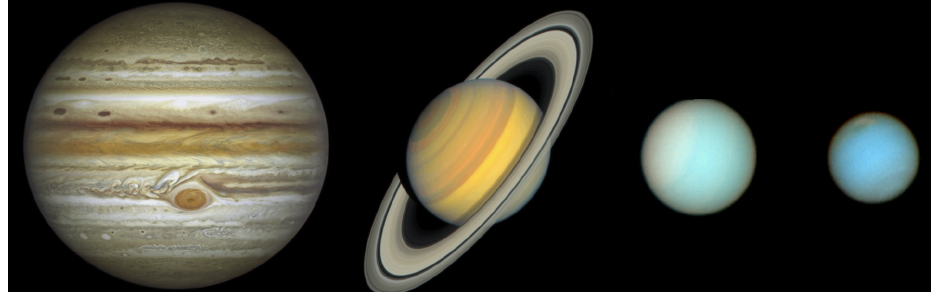
Figure 2. The giant planets’ appearance at UV and visible wavelengths from Hubble. Quasi-true color images from WFC3 data from the OPAL program show the differences amongst the planets with Jupiter and Saturn having shades of red, yellow and brown, while Uranus and Neptune are bluer. These color composites are comprised of the F631N (R), F502N (G), and 395N (B) filters for Jupiter (2021) and Saturn (2021) and F657N (R), F547M (G), and F467M (B) filters for Uranus (2015) and Neptune (2018). Images are not to